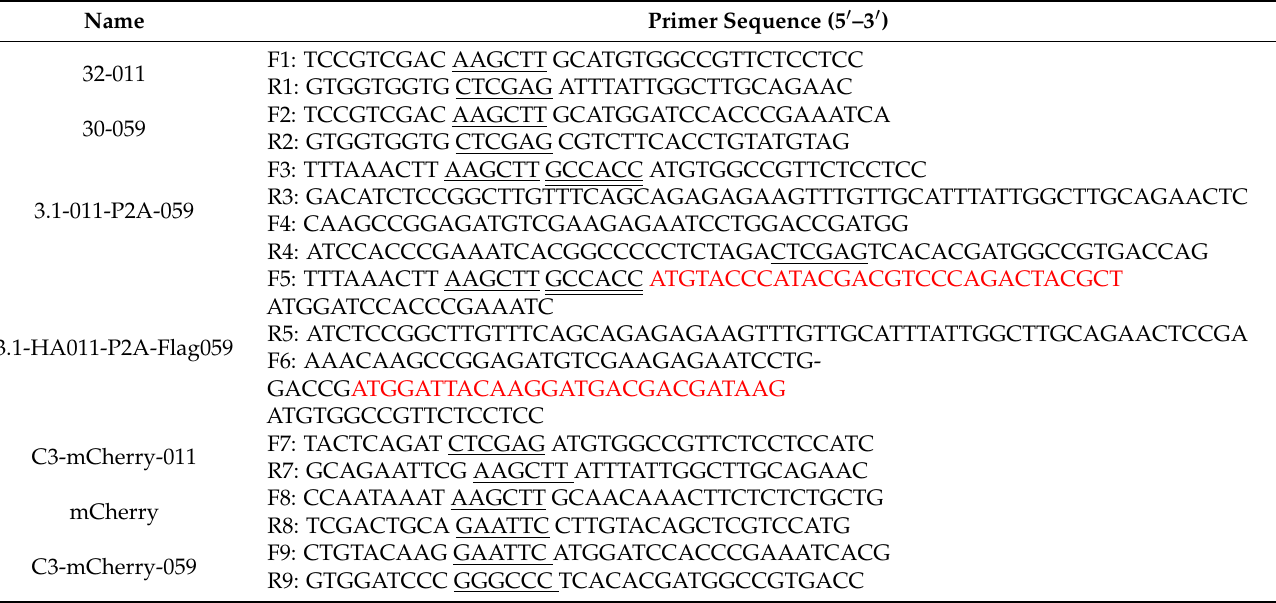
Table 1. Primer sequences used in the